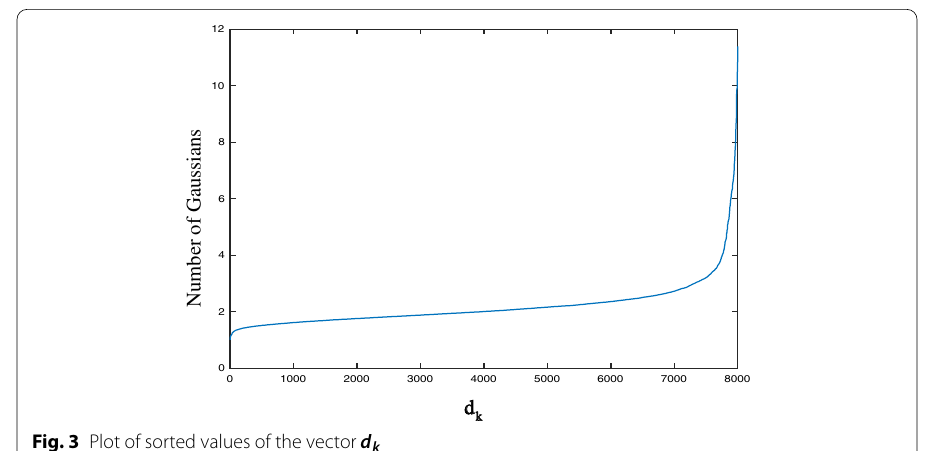
Fig. 3 Plot of sorted values of the vector d